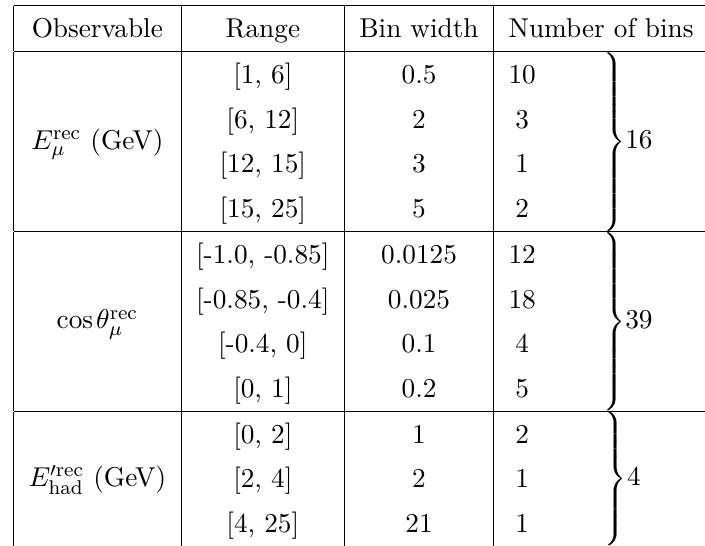
Table 4 . The optimized binning scheme considered for the numerical analysis of the present work for reconstructed observables E rec